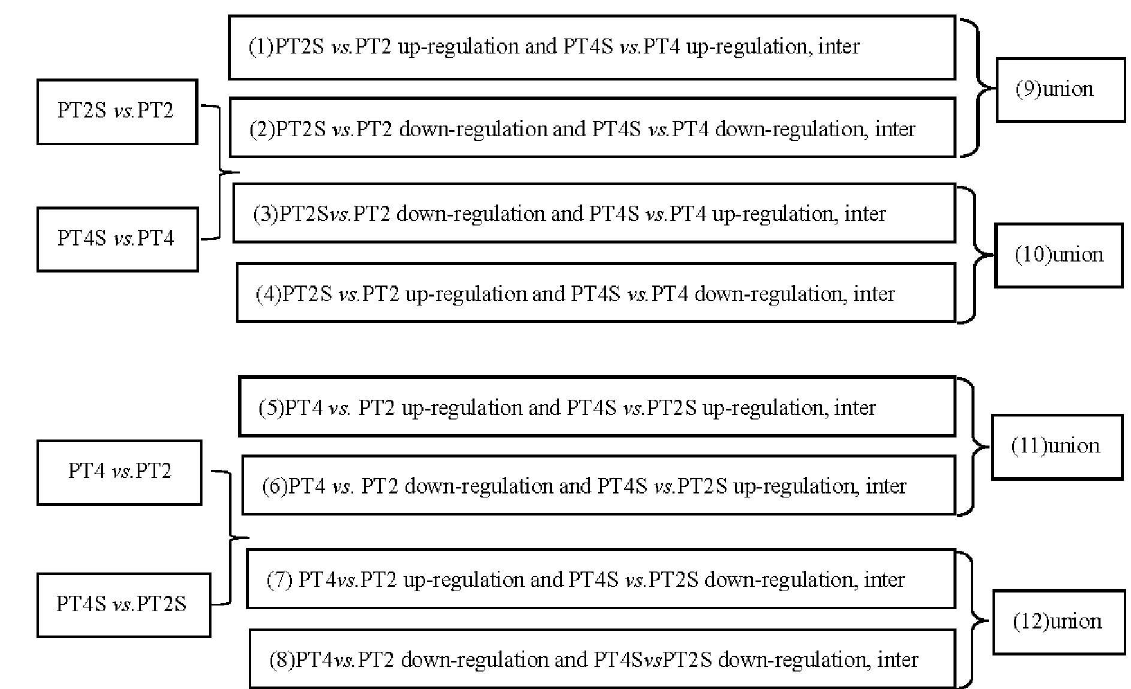
Fig 1. Comparison schemes of the four